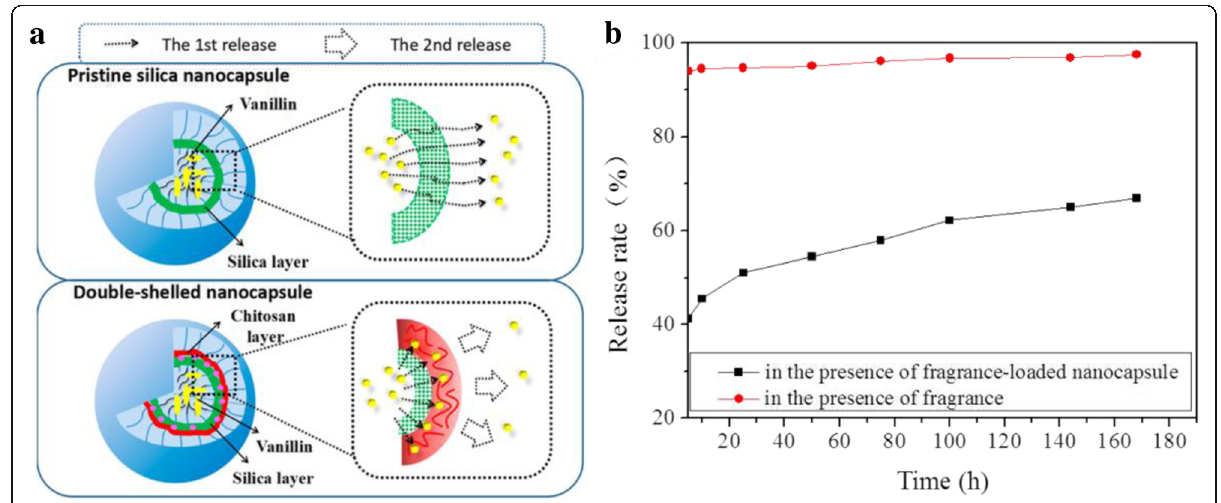
Fig. 7 Scheme of vanillin release from pristine silica capsule and double-shelled nanocapsule ( a ); Vanillin release rate of the leather samples finished by vanillin-loaded chitosan-based silica nanocapsules (red line) and vanillin (black line) ( b )[62, 63]. Copyright 2018, American Chemical